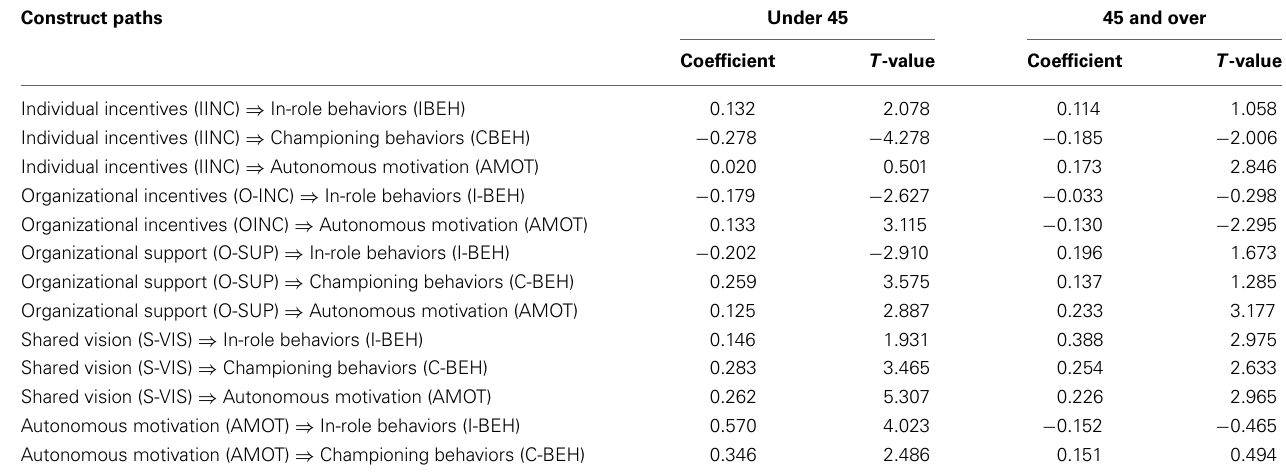
Table 8 | Results of multigroup analysis for managers over and under 45 years old. Construct paths